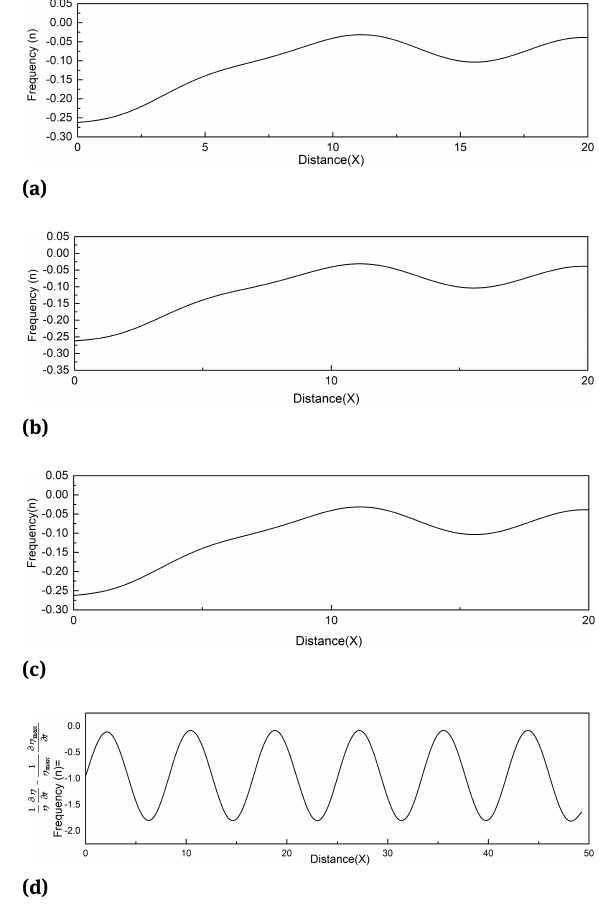
Fig. 6: Comparison between full numerical wave number of ˆ (cid:96) = 0.75 and the couple stress. Parameter M with fixed values of β = 2 , B =0.02 and β ( from top to